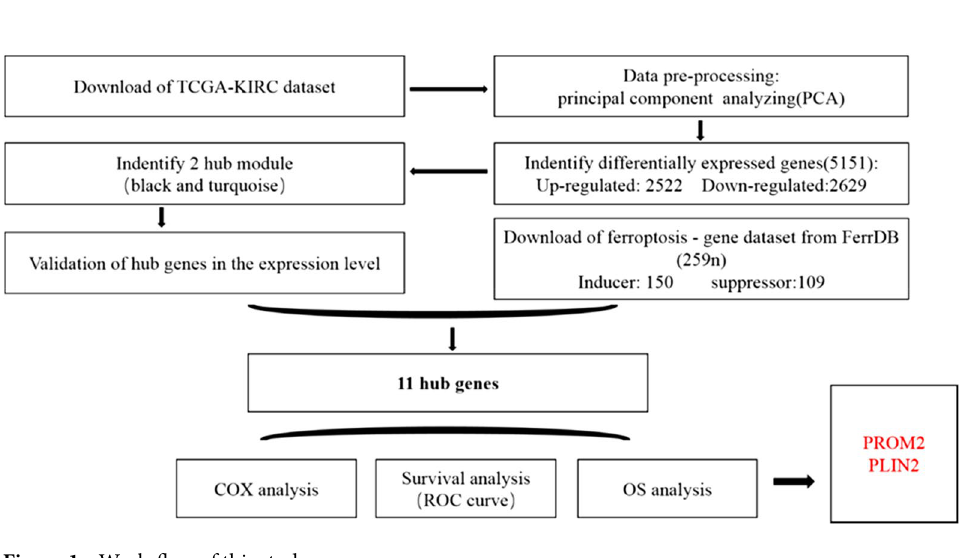
Figure 1. Work-flow of this